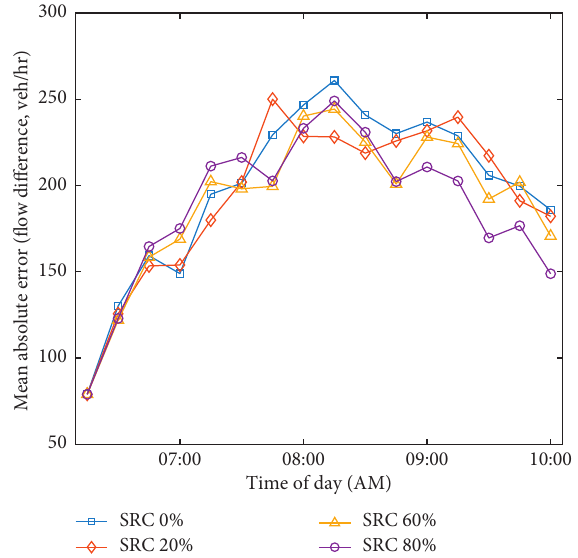
Figure 6: Mean absolute error (MAE) for individual link flows at time t (6–10 AM) from the SRC model with different adaptive driving compared to the DUE. X -axis represents the time of the day and y -axis is the MAE in